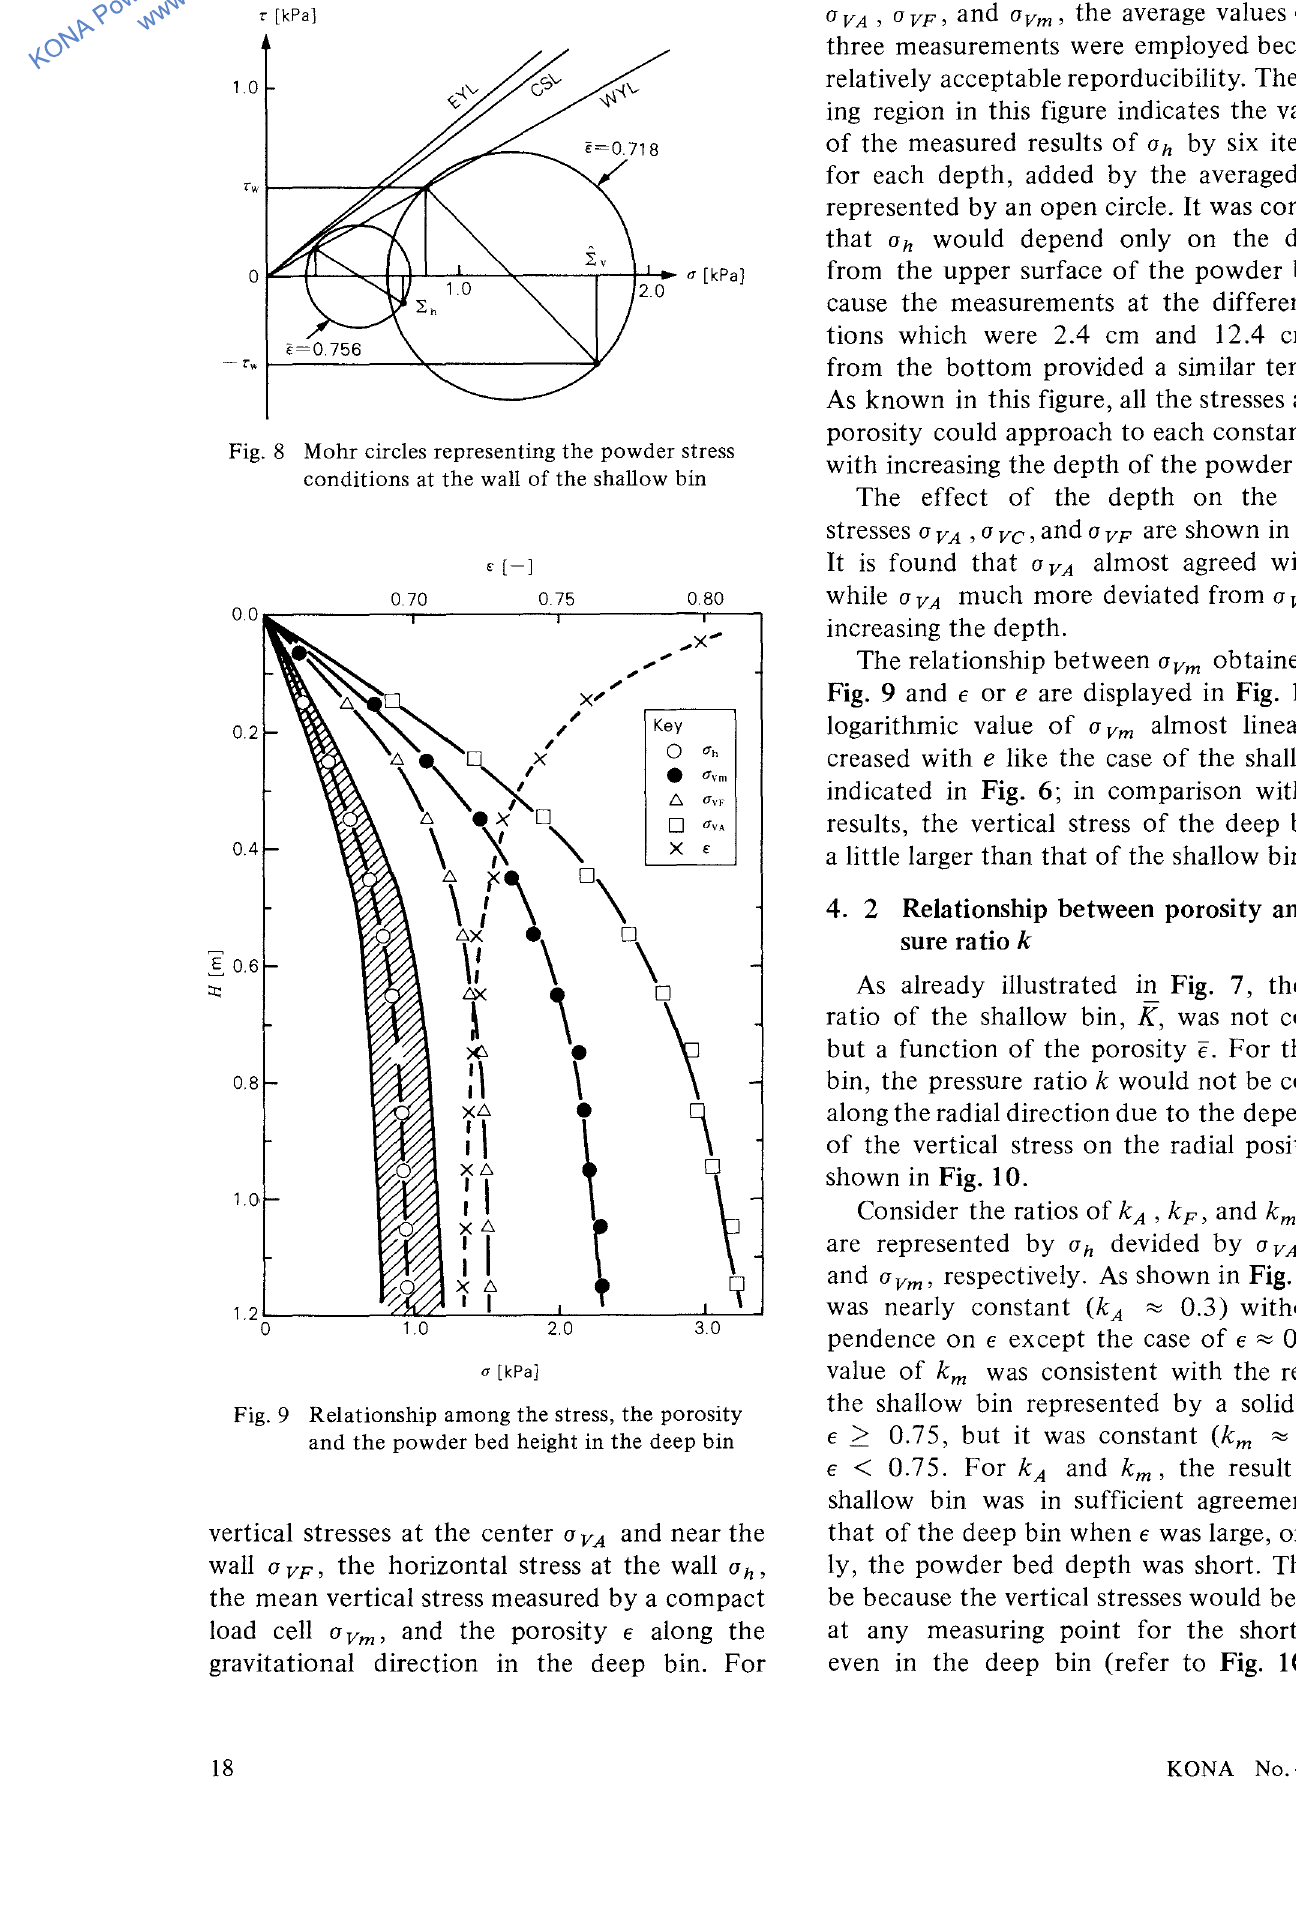
Fig. 9 Relationship among the stress, the porosity and the powder bed height in the deep bin